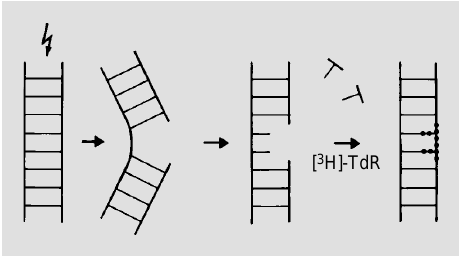
Figure 1 - Scheme of DNA exci- sion repair. The rope ladder rep- resents the DNA double helix. After X-irradiation, but also spo- radically, single strand breaks oc- cur. A few steps of this repair are shown. Around the point of fracture, a few bases are snipped out which will be newly synthe- sized and inserted into the DNA strand (dots). If [ 3 H]-thymidine ([ 3 H]-TdR) is applied, DNA repair synthesis (unscheduled nuclear DNA synthesis) can be shown autoradiographically. Figure 2 - Autoradiographs of Feulgen-prestained and light green-poststained paraffin sec- tions showing comparable parts of the cortex 1 h after [ 3 H]-TdR injection of a 6-month-old mouse (a), or of a control mouse which received no [ 3 H]-TdR (b). The two autoradiographs were processed under identical conditions and exposed for 250 days. Bar, 10